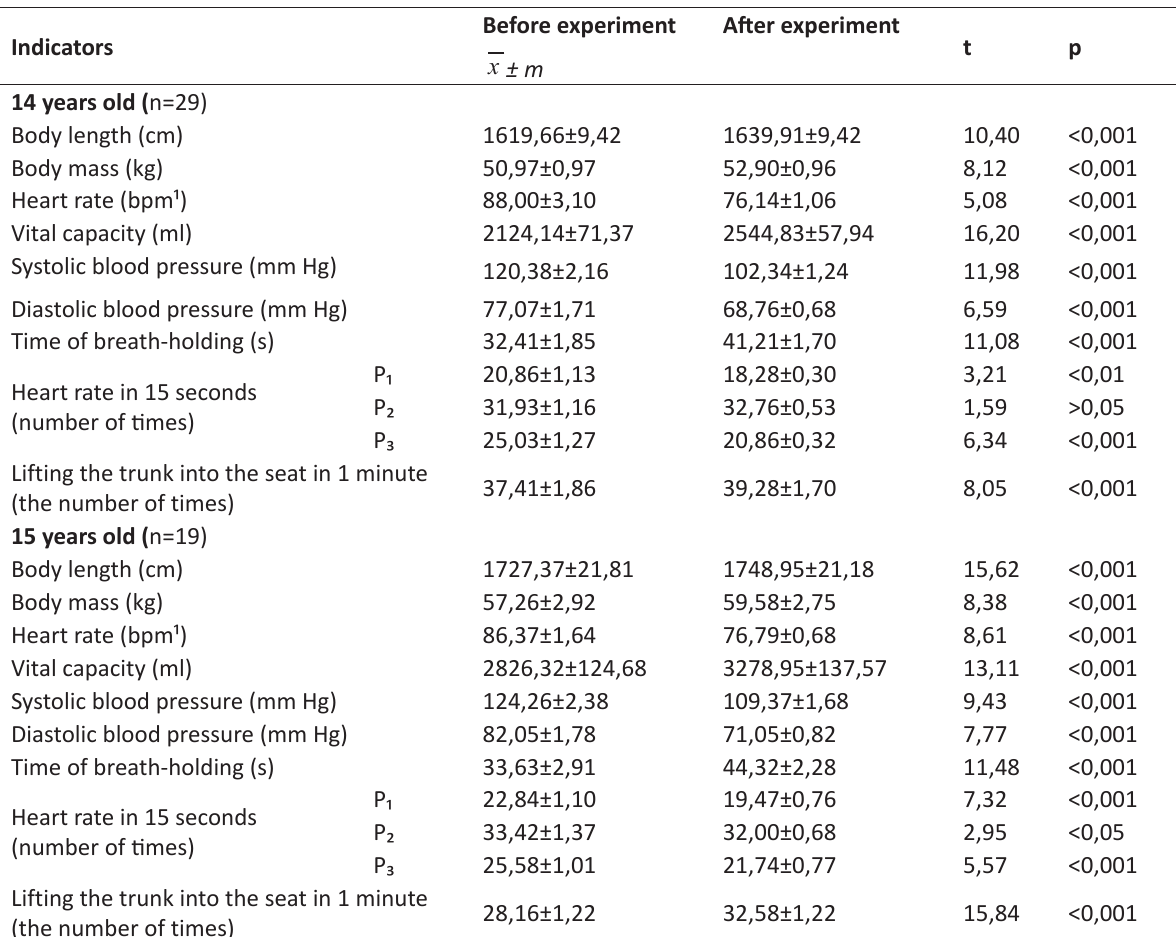
Table 2. Physical health indicators of boys of experimental groups before and after the experiment Before experiment After Indicators